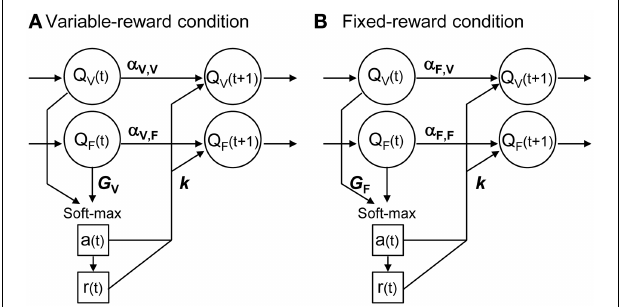
FIGURE 2 | Interferencereinforcementlearningmodel. Ourreinforcement learning models assumed that rats estimated expected rewards (values) of left and right choices in both variable- and fixed-reward conditions, i.e., Q V and Q F ; models had four action values in total. All action values were updated both in variable-reward-condition (A) and fixed-reward-condition (B) trials. α was the learning rate or forgetting rate in the selected or unselected option, respectively; α depended on the trial condition and value condition. k was the reinforcer strength of the outcome. A choice probability was predicted with a soft-max equation based on all values. The soft-max equation had a free parameter, G , which adjusted the contribution of action values from the non-trial condition in the choice